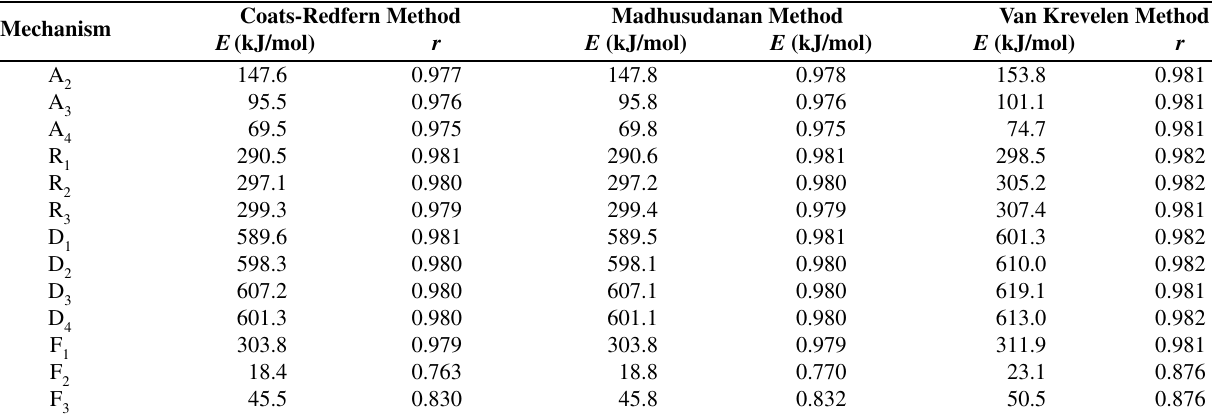
Table 3. Activation energies obtained for several solid state processes at a heating rate of 10 °C/min Coats-Redfern Method